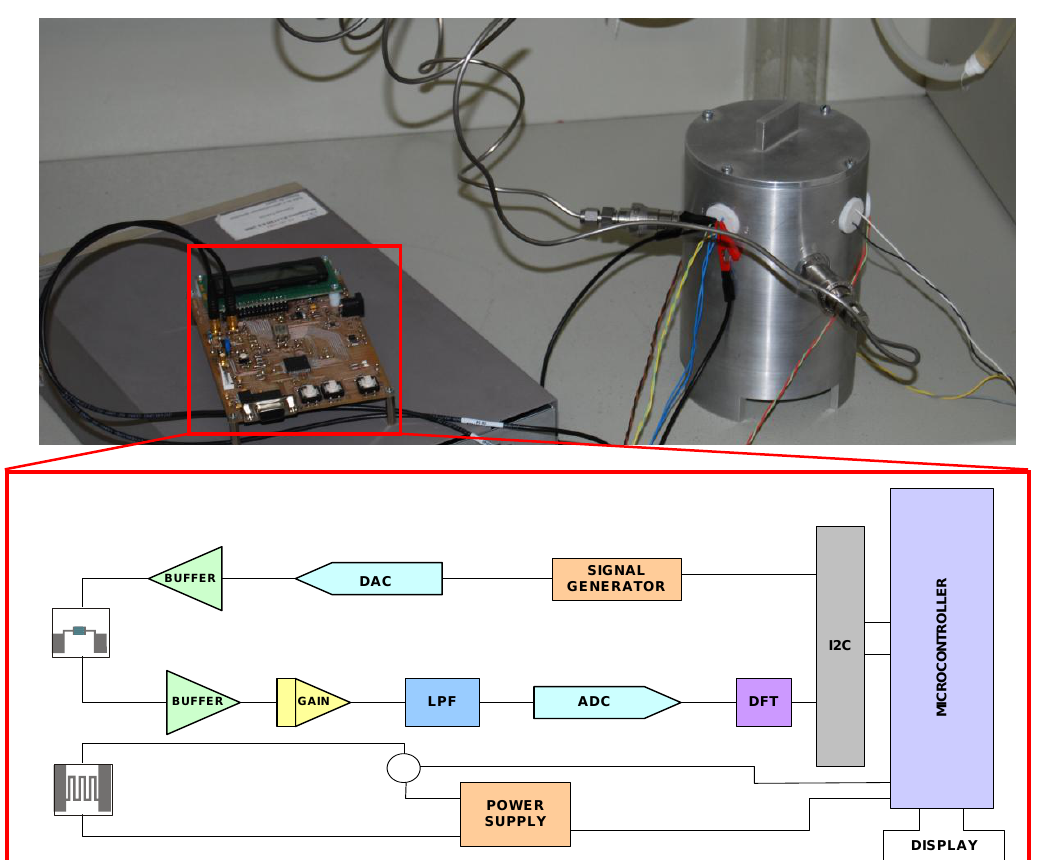
Figure 2. Signal conditioning circuit in test-bench and functional block